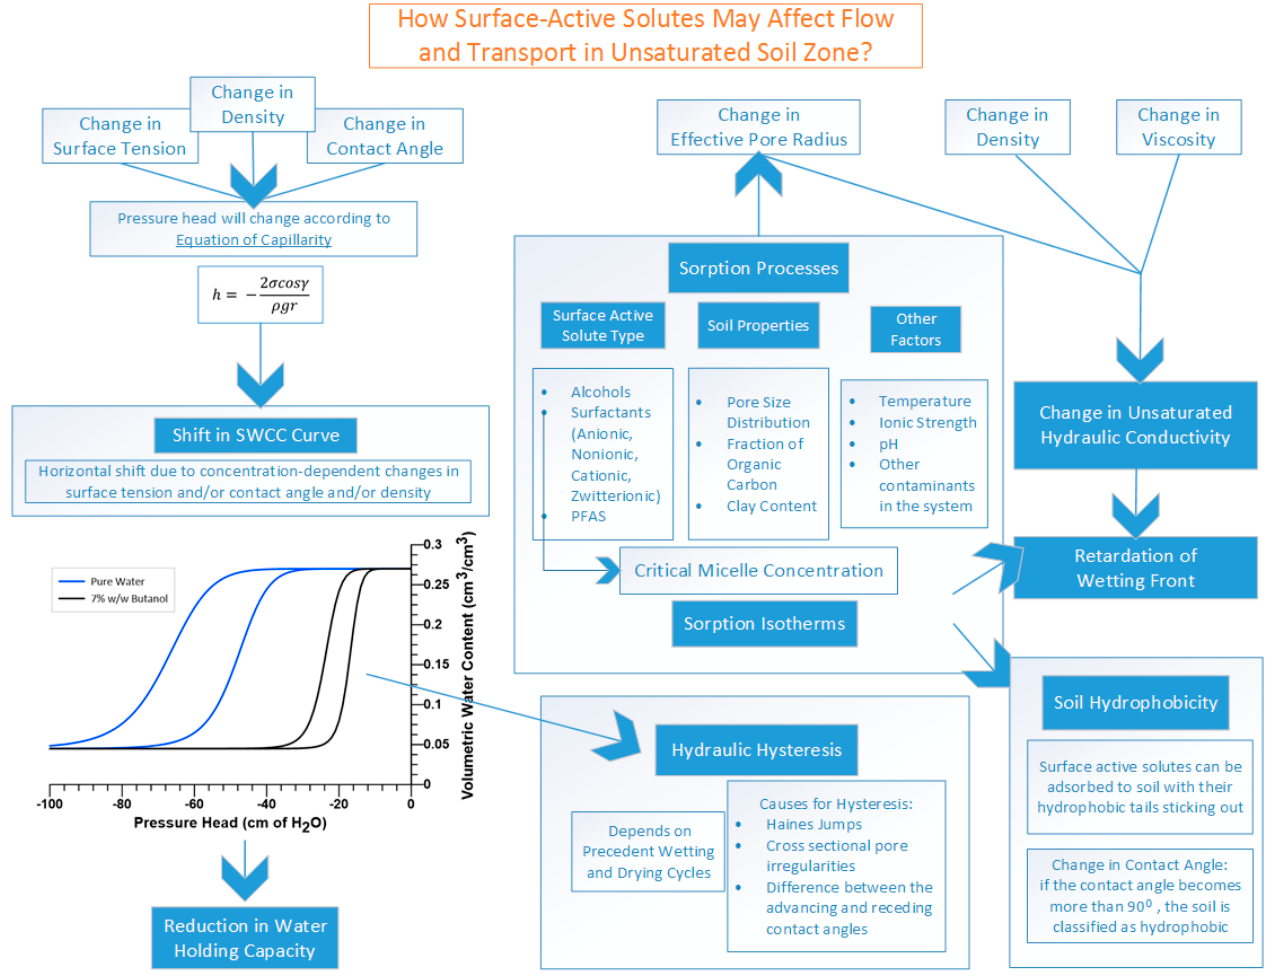
Figure 7. Summary of surface-active solutes’ effects on flow and transport in the unsaturated soil zone: a schematic representation.